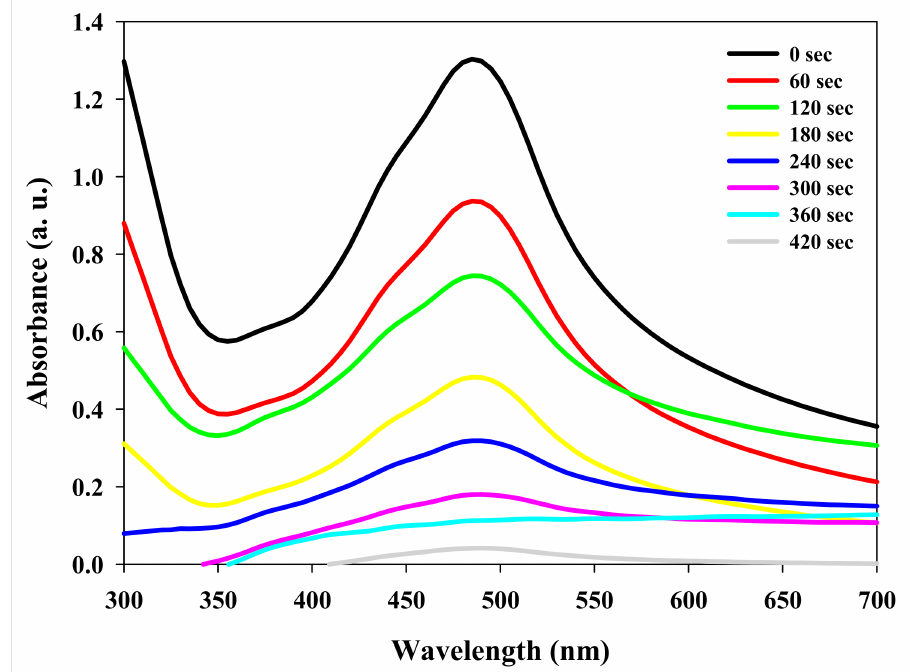
Figure 7. Time course photocatalytic degradation of Reactive Yellow 4G by developed LS–Ag NPs + H 2 O 2 system under UV-light